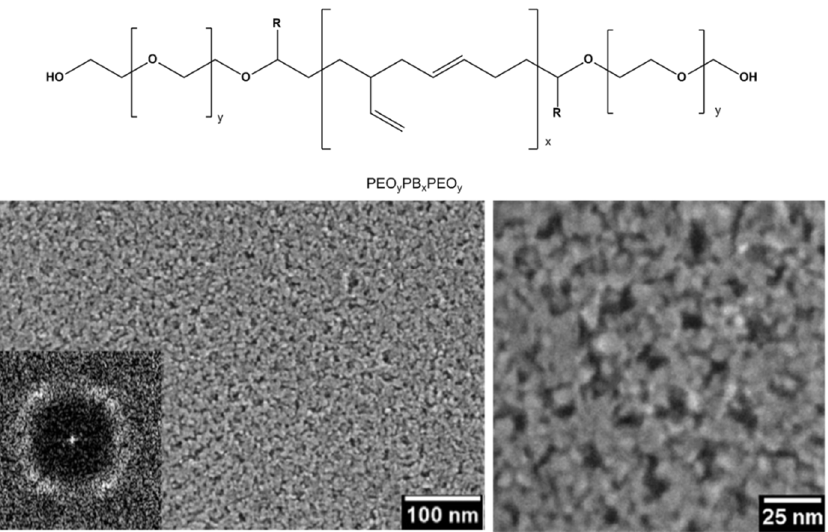
Figure 17. SEM images of IrO 2 mesoporous thin film template with PEO y -PB x -PEO y and calcinated at 500 °C (Reprinted/adapted with permission from Ref. [91]).